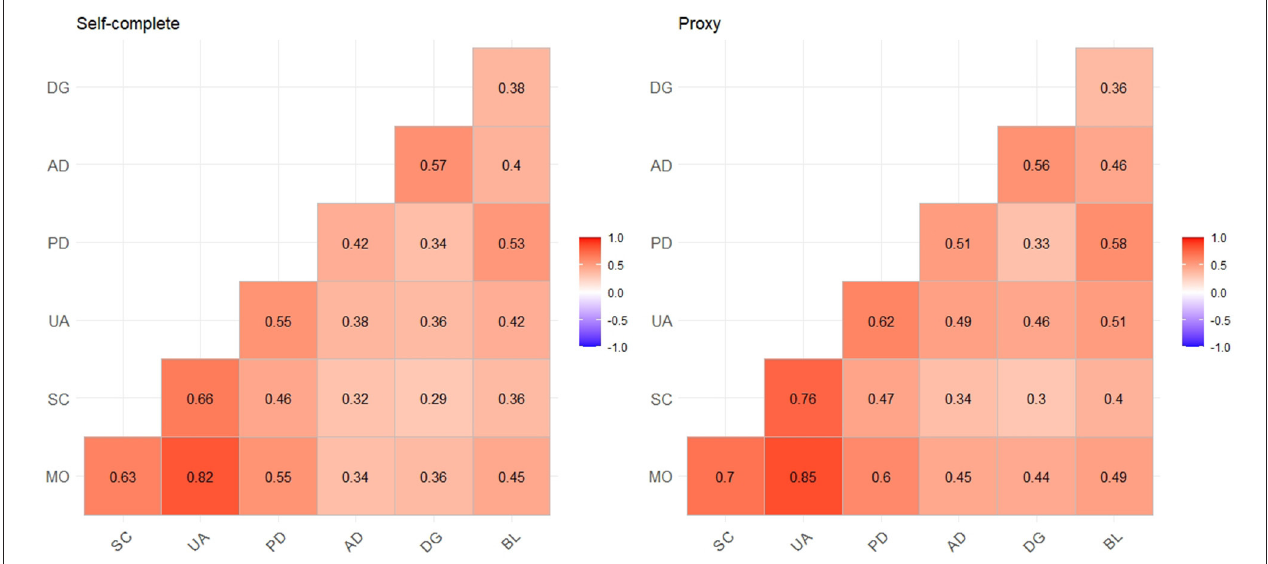
FIGURE 1 | Correlation between EQ-5D items and bolt-on items; MO, mobility; SC, self-care; UA, usual activates; PD, pain/discomfort; AD, anxiety/depression; DG, dignity; BL, bleeding; all the coefficients are statistically significant.